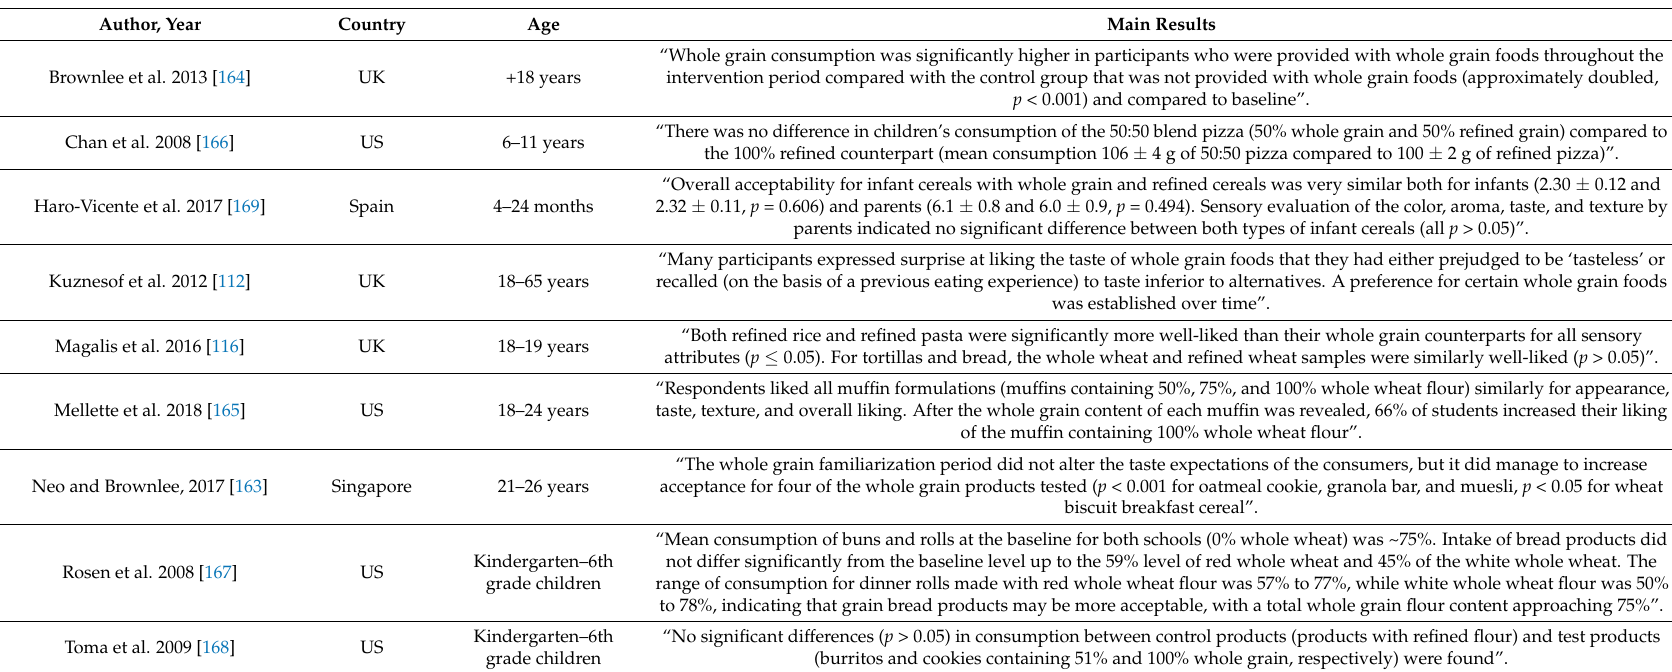
Table 4. Main findings of studies evaluating consumers’ sensory acceptability of whole grain